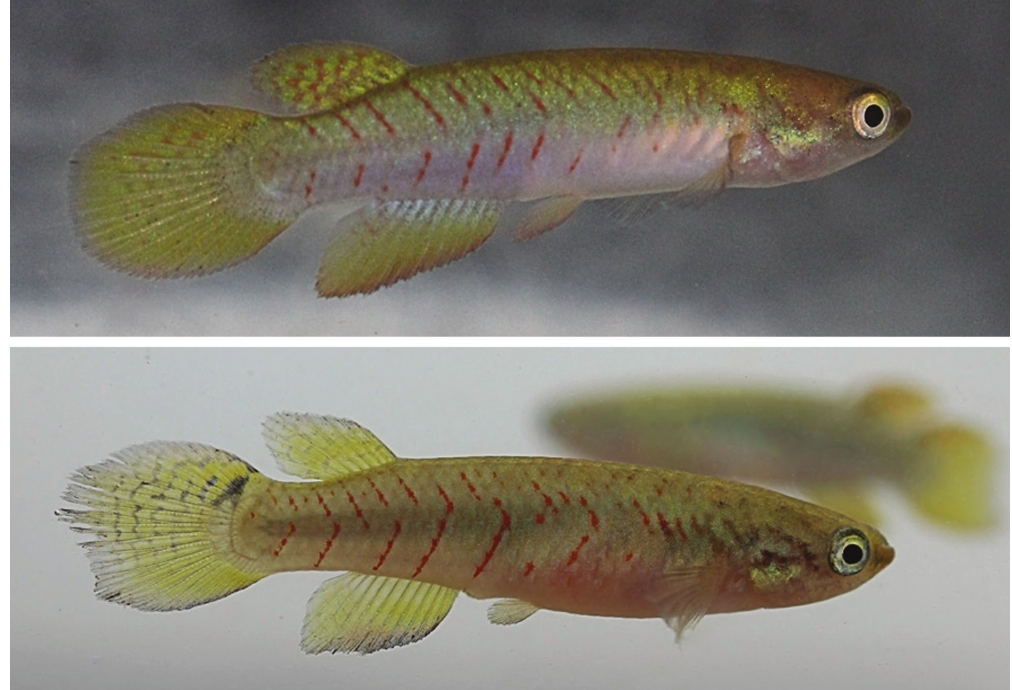
Figure 2. Melanorivulus interruptus sp. n., MCP 53146, paratypes, living male (above) and female (below), Campo Grande city, Mato Grosso do Sul state,